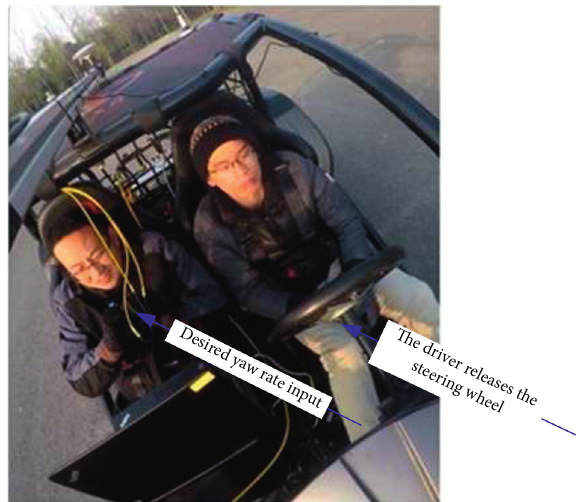
Figure 6: The field test of the differential